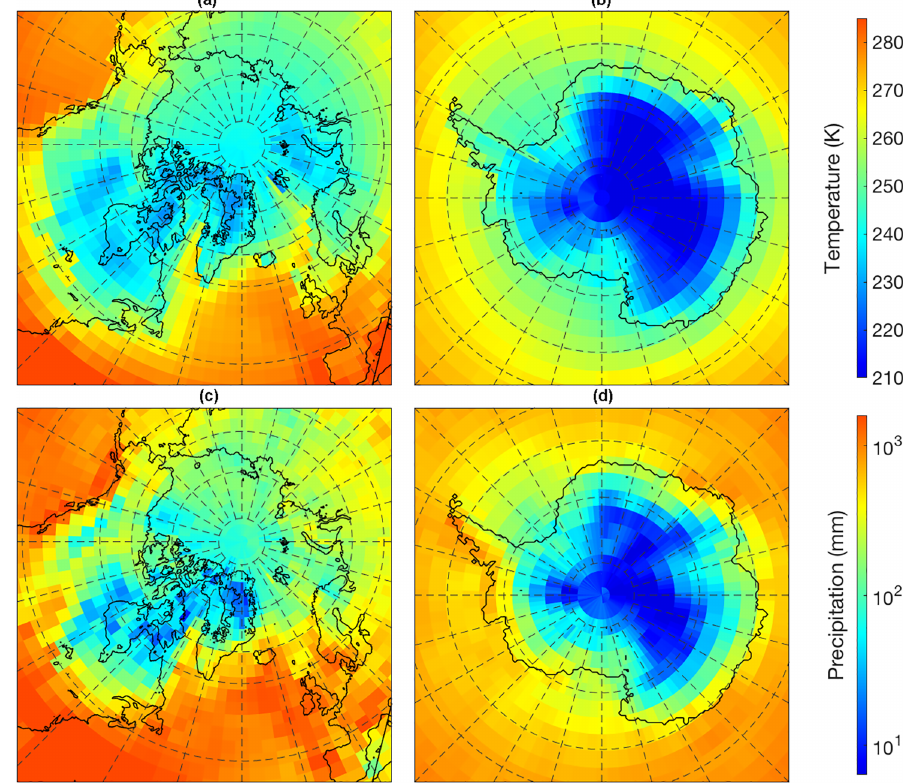
Figure 3. Annual mean 2m temperature for the Northern Hemisphere (a) and Antarctica (b) and the total annual precipitation (c, d) calculated with HadCM3 in the LGM experiment (Singarayer and Valdes,